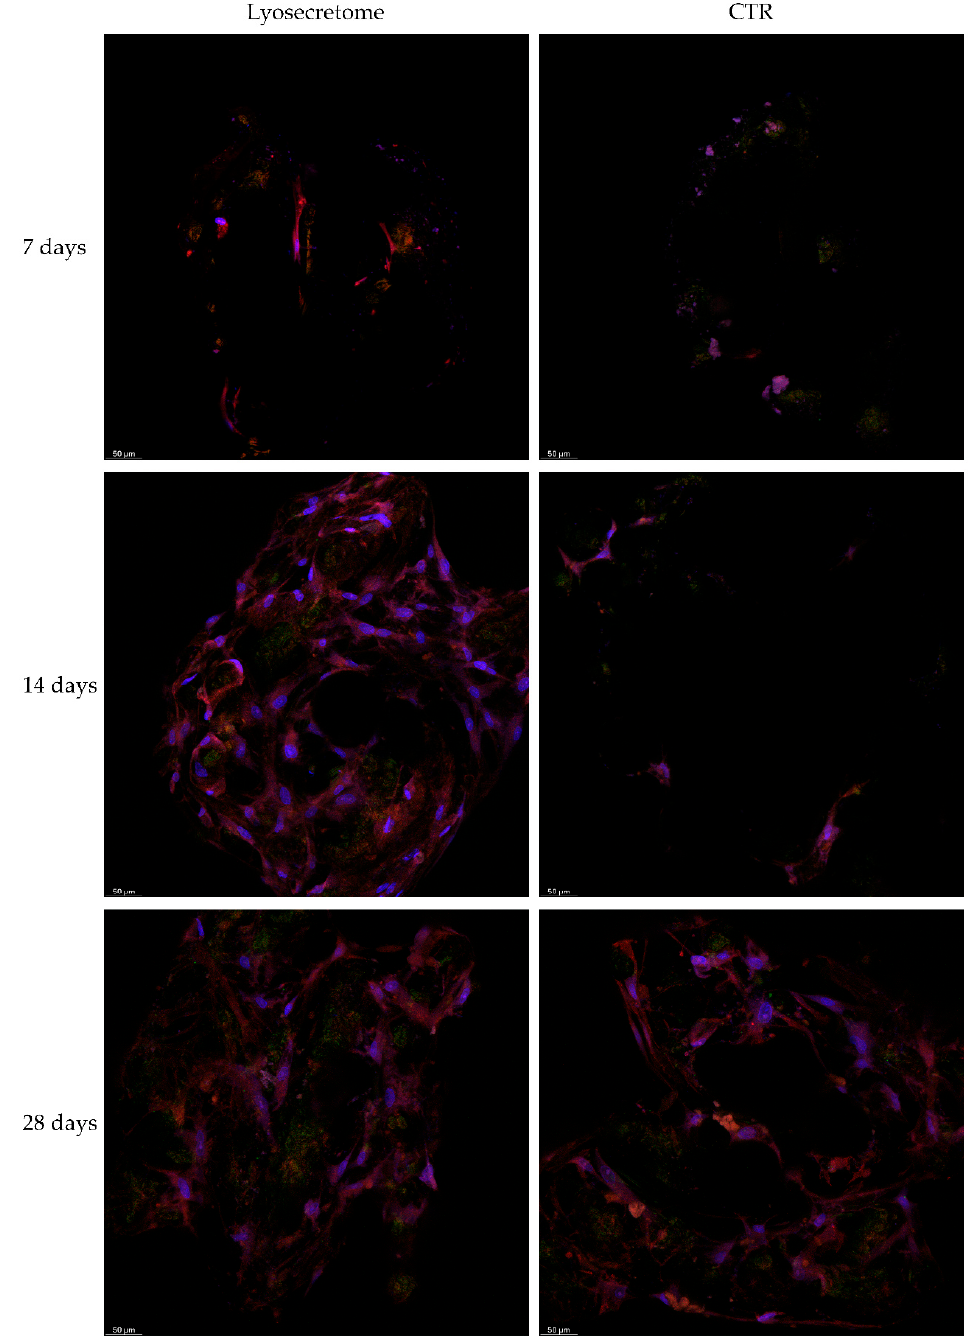
Figure 8. Confocal microscopy images of titanium cages seeded with MSCs and cultured in osteogenic medium with Lyosecretome or without (CTR) for 7, 14, and 28 days. Cell nuclei are stained in blue; actin cytoskeleton is stained in red, and mineralized matrix is stained in green. Scale bar: 50 µm.